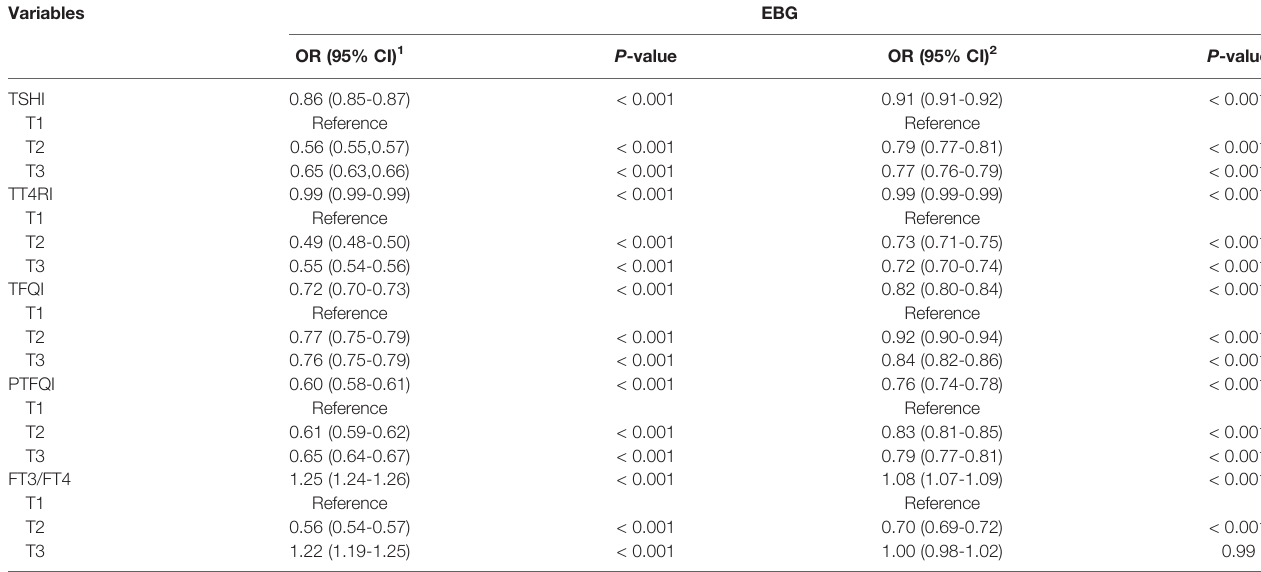
TABLE 2 | Relationship between thyroid hormone sensitivity and EBG.